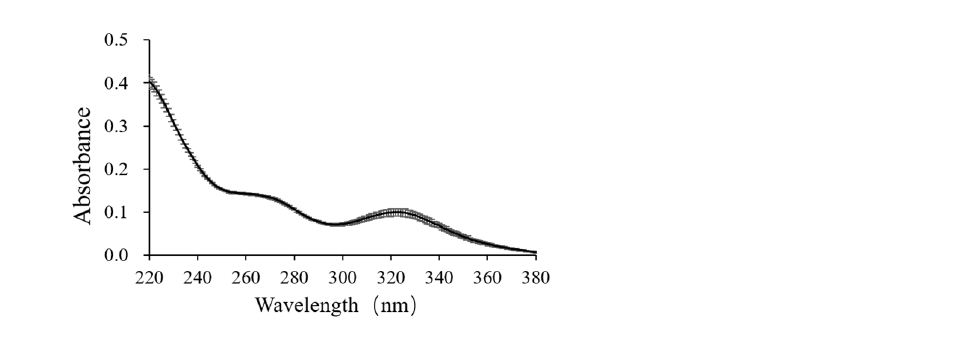
Figure 2. The absorbance at wavelengths of 220~380 nm after one-hour preparation of 100 µM Na 2 WO 4 ·2H 2 O. Table 2. Variation in the absorbance of 100 µM Na 2 WO 4 ·2H 2 O (pH = 3) with reaction time. Time